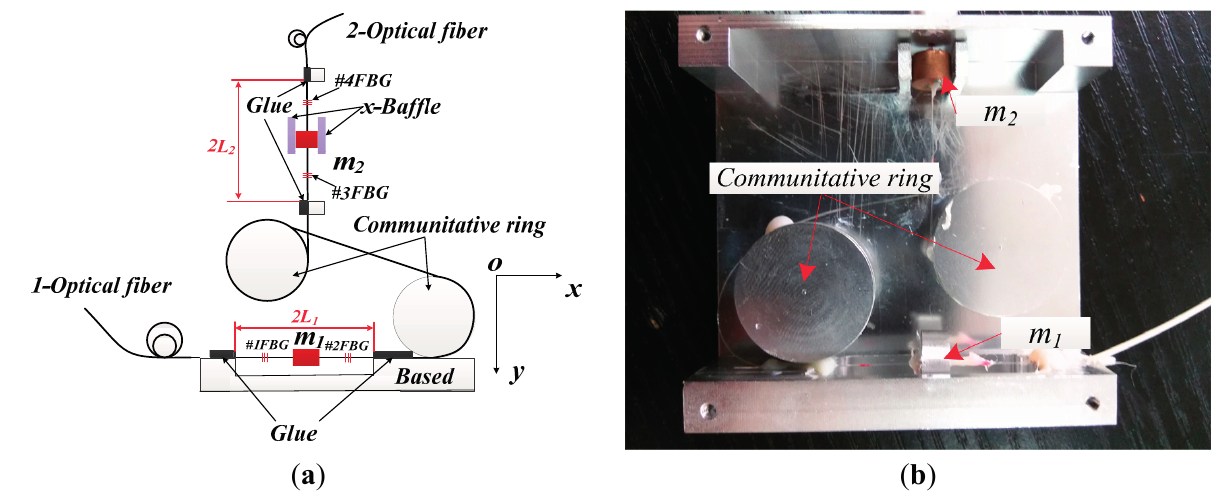
Figure 1. Schematic diagram and photograph of an FBG based triaxial vibration